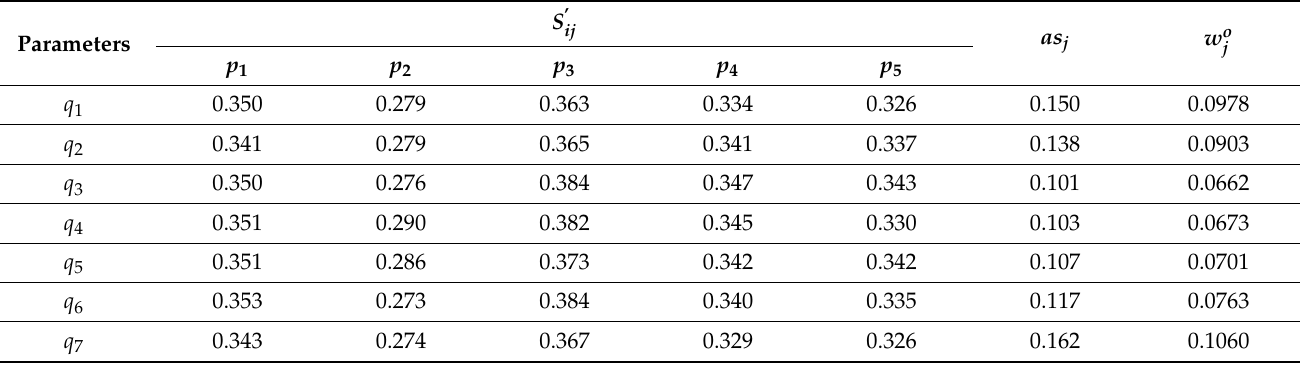
Table A4. Objective weight of criteria using IF-MEREC for prioritizing the